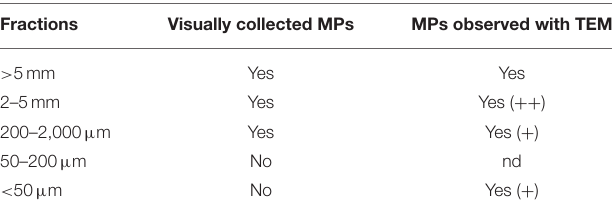
TABLE 4 | identification of the MPs presence in the compost fractions at photonic and electronic scales; “ + ” as indication of the observation frequency.